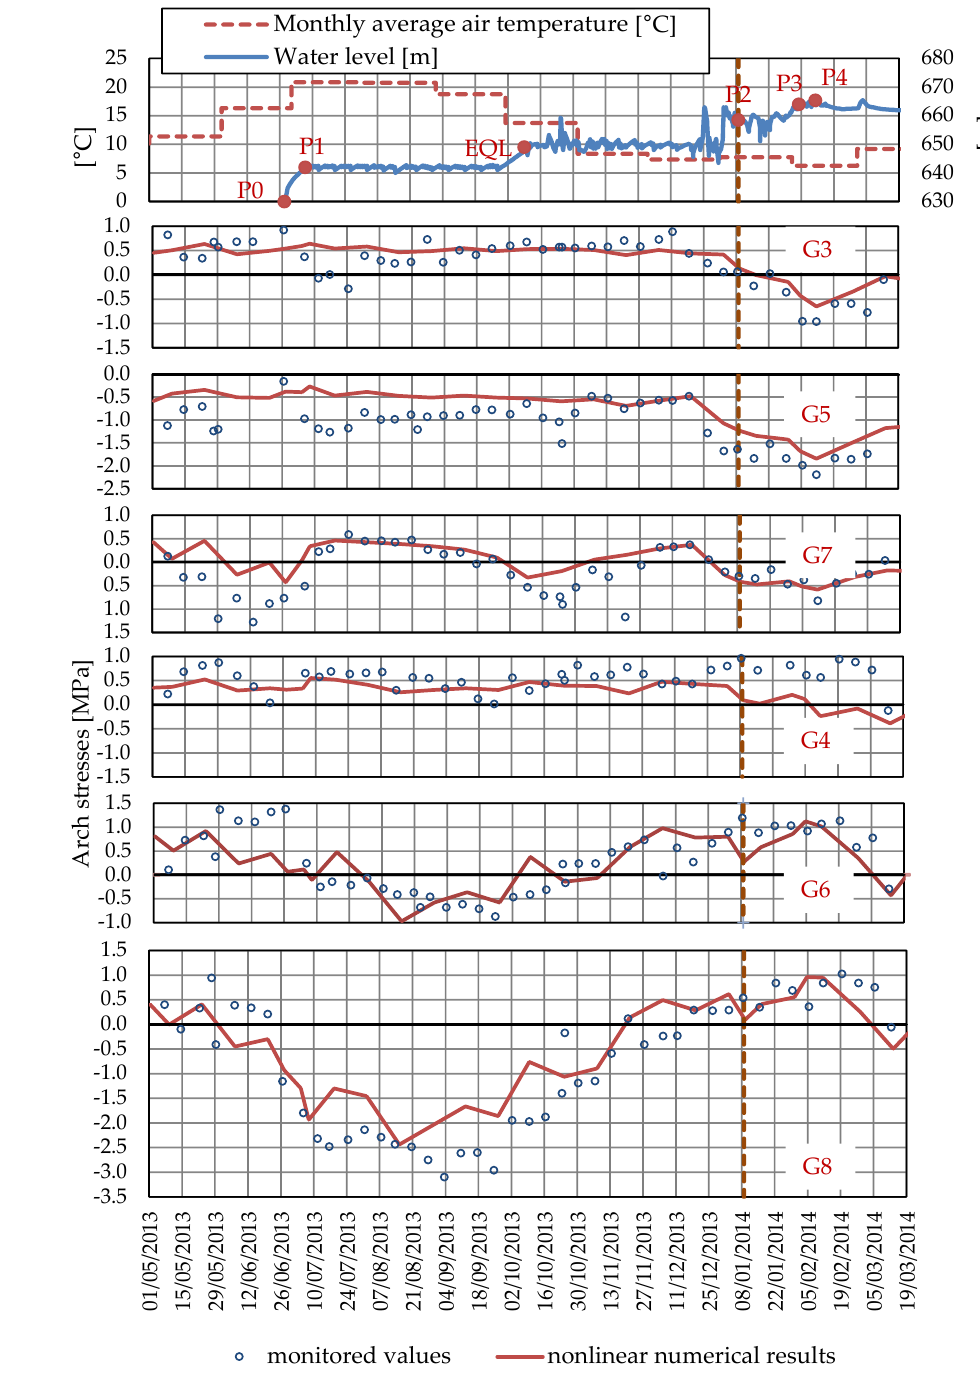
Figure 12. Monthly average air temperature, reservoir levels, and comparison of predicted stresses and values obtained from the strain-meter measurements.